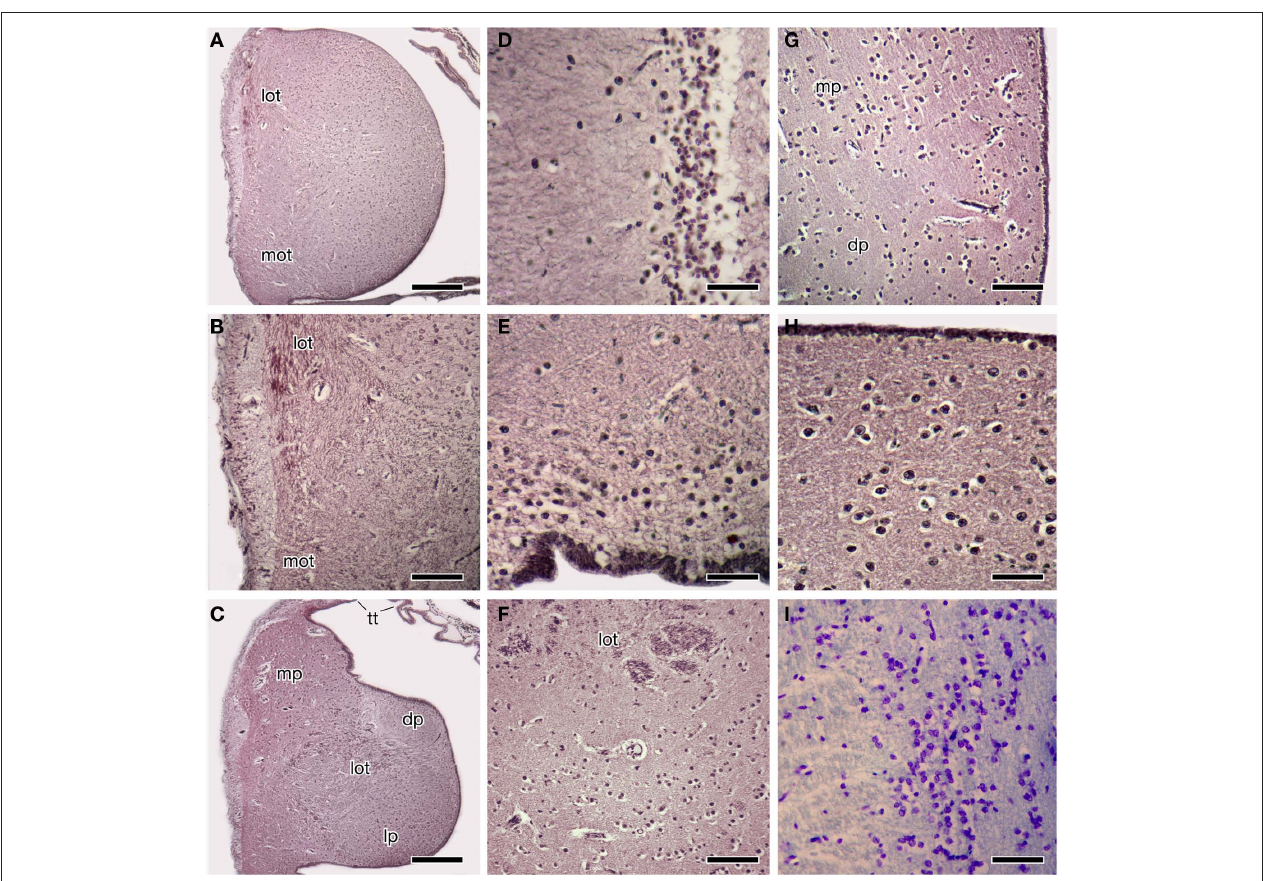
The cells of the central amygdalar nucleus. Sections in (A–H) are stained by the Bodian silver method; section I is stained with 1% cresyl violet. Scale bars = 100 μm (D,e,H,i) , 200 μm (B,F,g) , 500 μm (A,C) . dp, Dorsal pallium; lot, lateral olfactory tract; lp, lateral pallium; mot, medial olfactory tract, mp, medial pallium; tt telencephalic